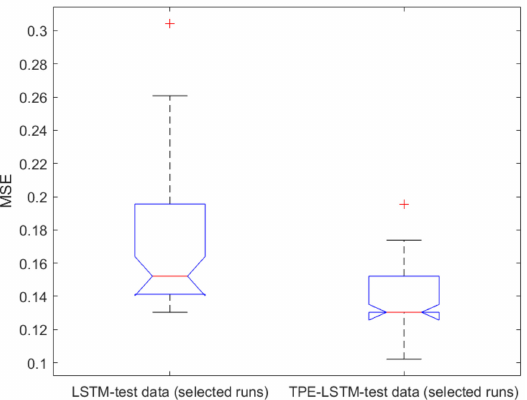
Figure 4. MSE: test data, 52% runs with improvement applied. LSTM versus TPE-LSTM.